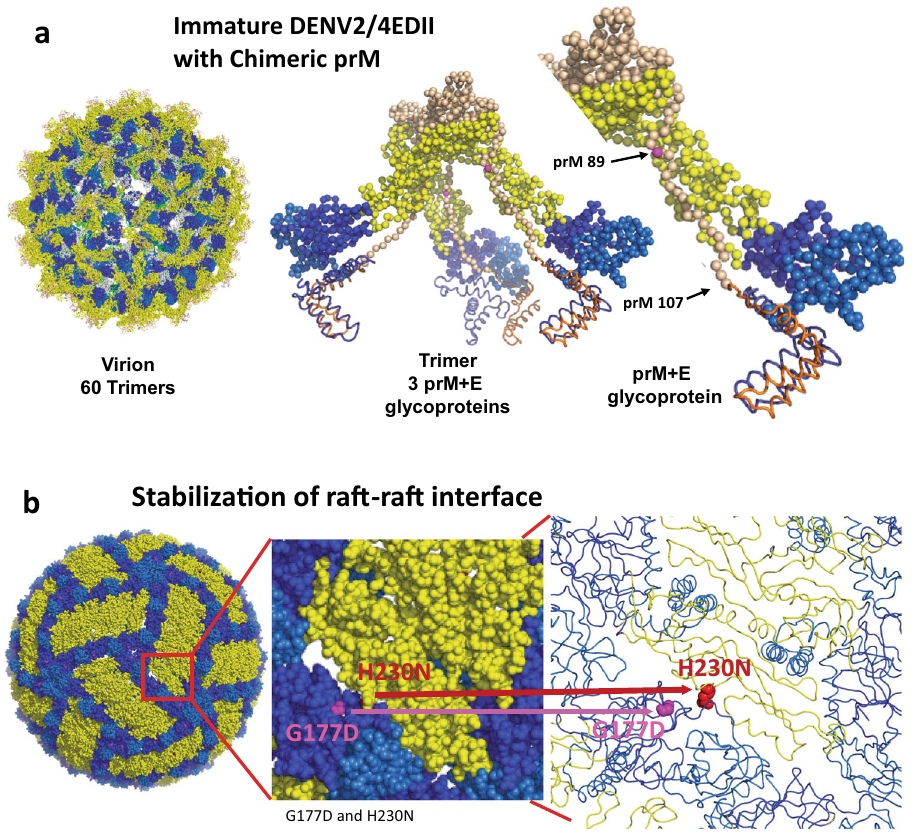
Fig. 2 | Molecular models of chimeric prM and Tissue Culture Adaptive Muta- tions. a The immature DENV2/4EDII virion, which is composed of 60 prM+E tri- mers, is shown beside a trimer of prM+E and a monomer of prM+E glycoproteins. The E glycoprotein is represented in dark blue (EDI), yellow(EDII) and medium blue(EDIII)sphereswiththestemandmembranealpha-helixesindarkblueribbon. The DENV4 portion of the chimeric prM, aa 1-107, is shown in tan spheres and the